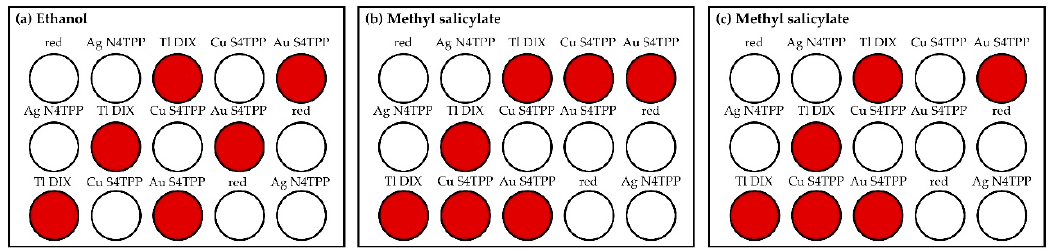
Figure 7. Indicator spot maps for the sensor located at position F (Figure 4) during exposure to ethanol ( a ) and methyl salicylate ( b , c ). Red circles are used to identify indicators that gave a positive response.